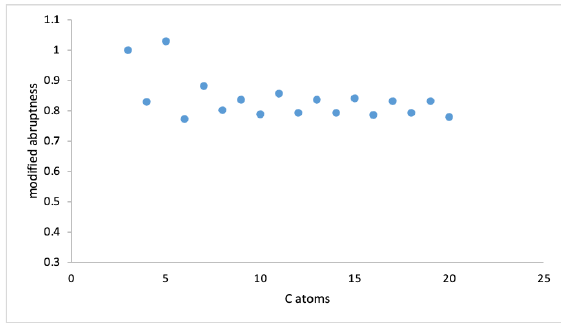
Figure 9. Distribution of modified abruptness of graph